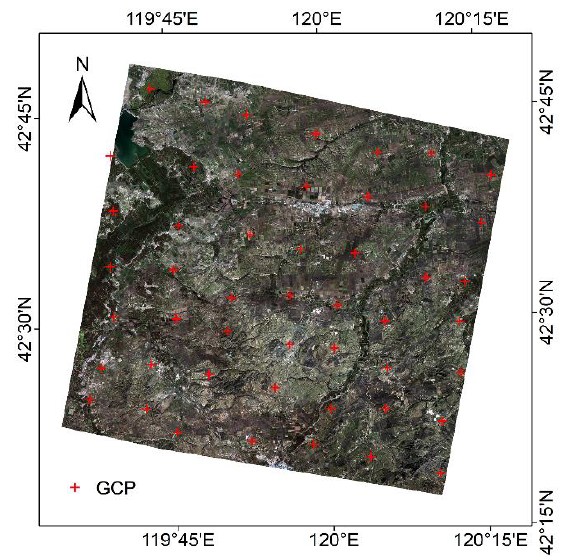
Figure 4. Locations of all 49 GCPs on the true color composite ZY3-02 multispectral image.